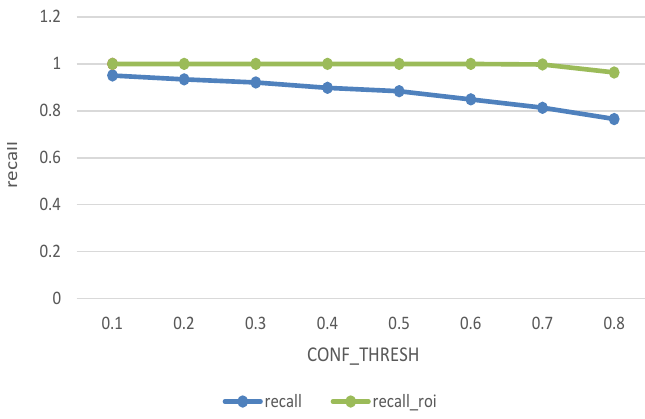
Figure 14. The recall rate under different CONF_THRESH value.